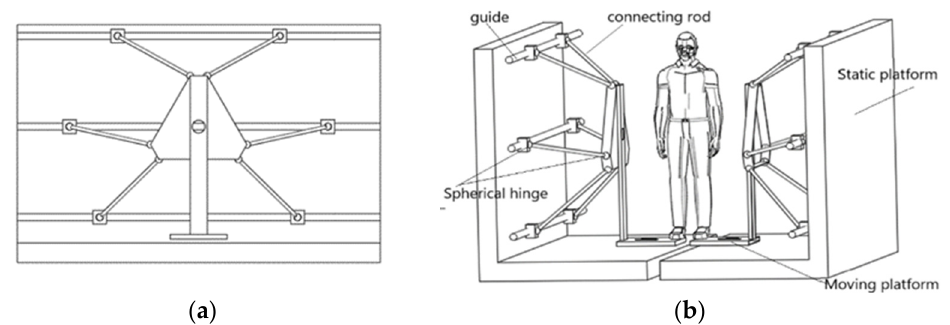
Figure 5. Schematic diagram of robot structure. ( a ) Structure diagram of unilateral robot. ( b ) Structure diagram of the whole machine